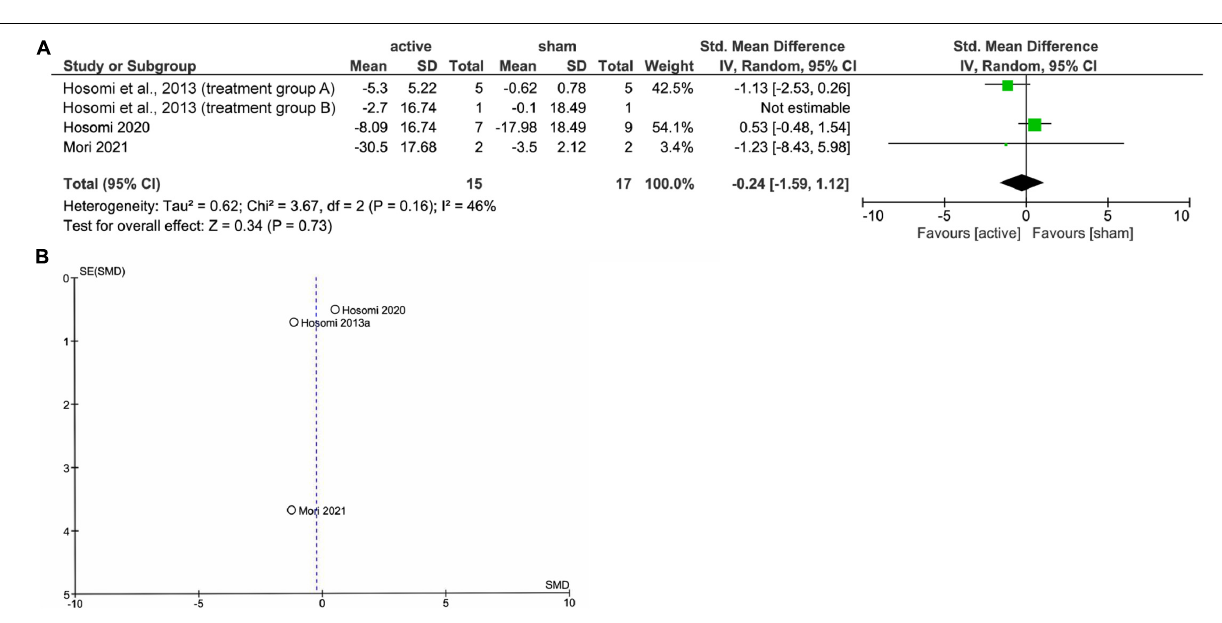
FIGURE 4 | The forest plot (A) and funnel plot (B) of the analysis for the facial